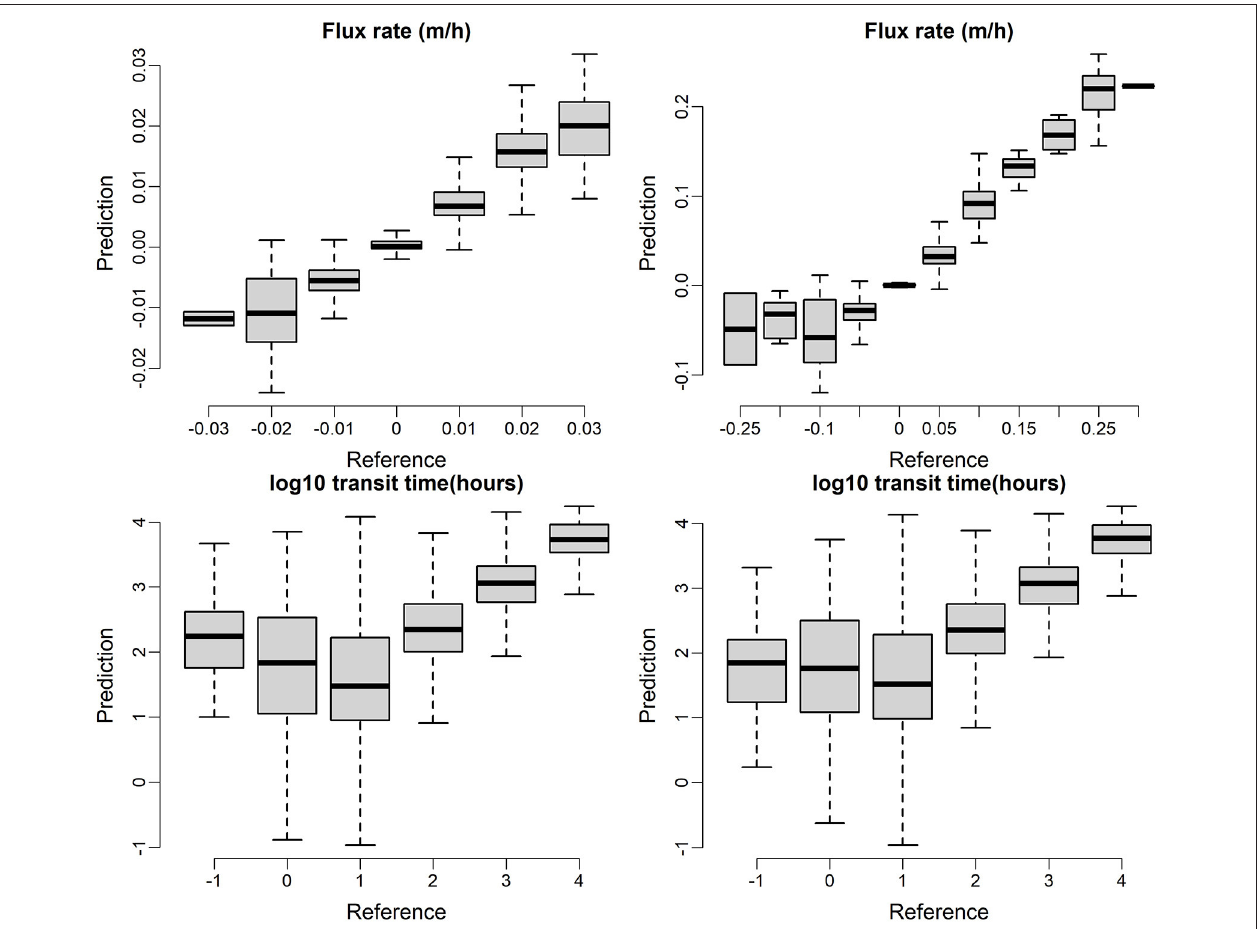
FIGURE 11 | XGB model predictions for exchange flux (top) and transit time (bottom) on testing dataset for homogenous (left) and heterogenous (right)